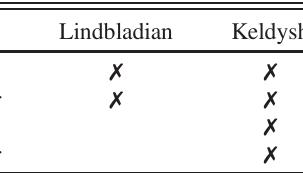
Irrespective of the different realizations of individual TABLE I. Principal types of dissipative dynamics and their